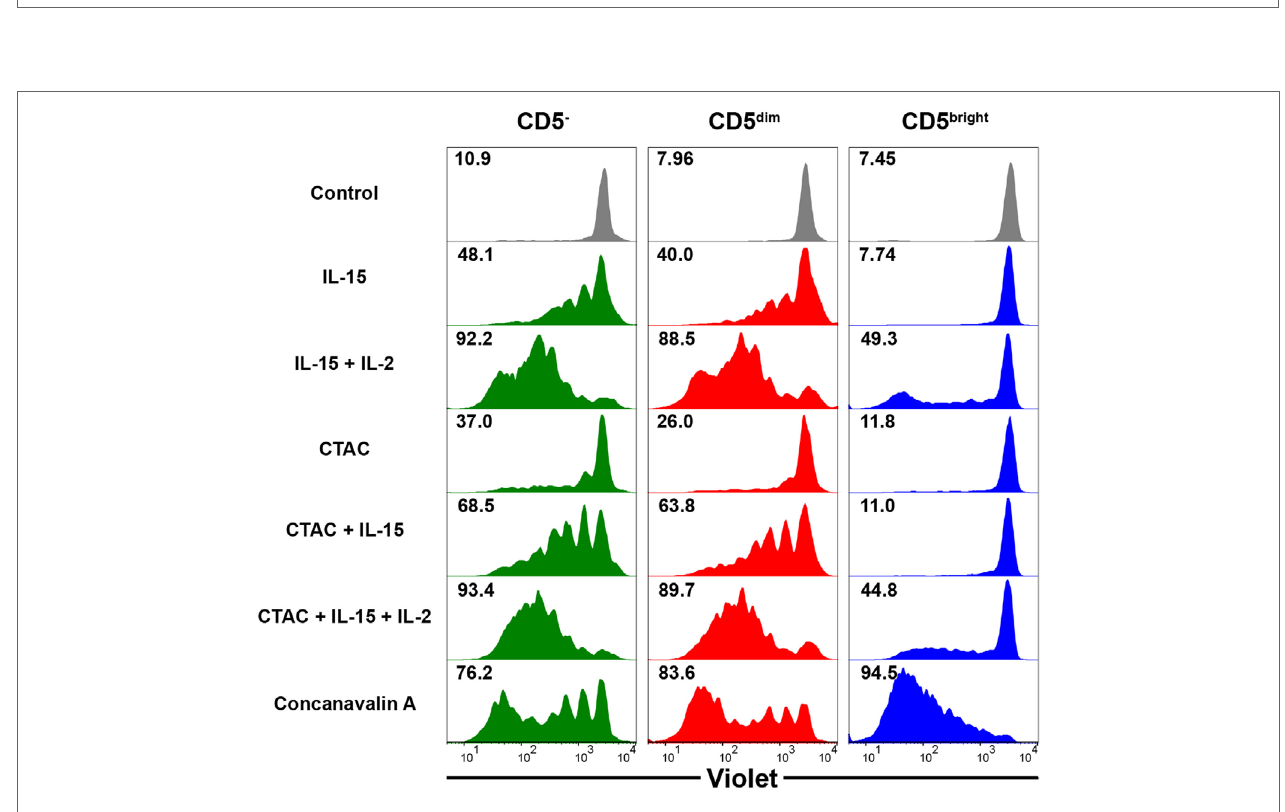
FigUre 5 | Expression of the T-box transcription factors, T-box expressed in T cells (T-bet) and Eomesosermin (Eomes) in each lymphocyte subset in relation to the expression of CD3, CD5, and CD21 before and after culture of PBMCs. (a) Expression of T-bet and Eomes in CD3 + CD5 dim CD21 − (red), CD3 + CD5 bright CD21 − (blue), and CD3 − CD5 − CD21 − (green) lymphocytes before culture. The results shown represent those obtained from one of nine different donors. (B) The percentage of cells expressing T-bet, Eomes, and both factors in CD3 + CD5 dim CD21 − (CD5 dim ), CD3 + CD5 bright CD21 − (CD5 bright ), and CD3 − CD5 − CD21 − (CD5 − ) lymphocytes before culture ( n = 9). (c) Expression of T-bet and Eomes in CD3 + CD5 dim CD21 − (CD5 dim , red), CD3 + CD5 bright CD21 − (CD5 bright , blue), and CD3 − CD5 − CD21 − (CD5 − , green) lymphocytes 2 weeks (2w) after culture, and in CD3 − CD5 − CD21 − cells 3 weeks (3w) after culture. The results shown represent those obtained from one of nine different donors. (D) The percentage of cells expressing T-bet, Eomes, and both factors in CD3 + CD5 dim CD21 − (CD5 dim ), CD3 + CD5 bright CD21 − (CD5 bright ), and CD3 − CD5 − CD21 − (CD5 − ) lymphocytes 2 (2w) or 3 weeks (3w) after culture ( n = 9) (* p < 0.01, ** p < 0.005, and *** p < 0.001).